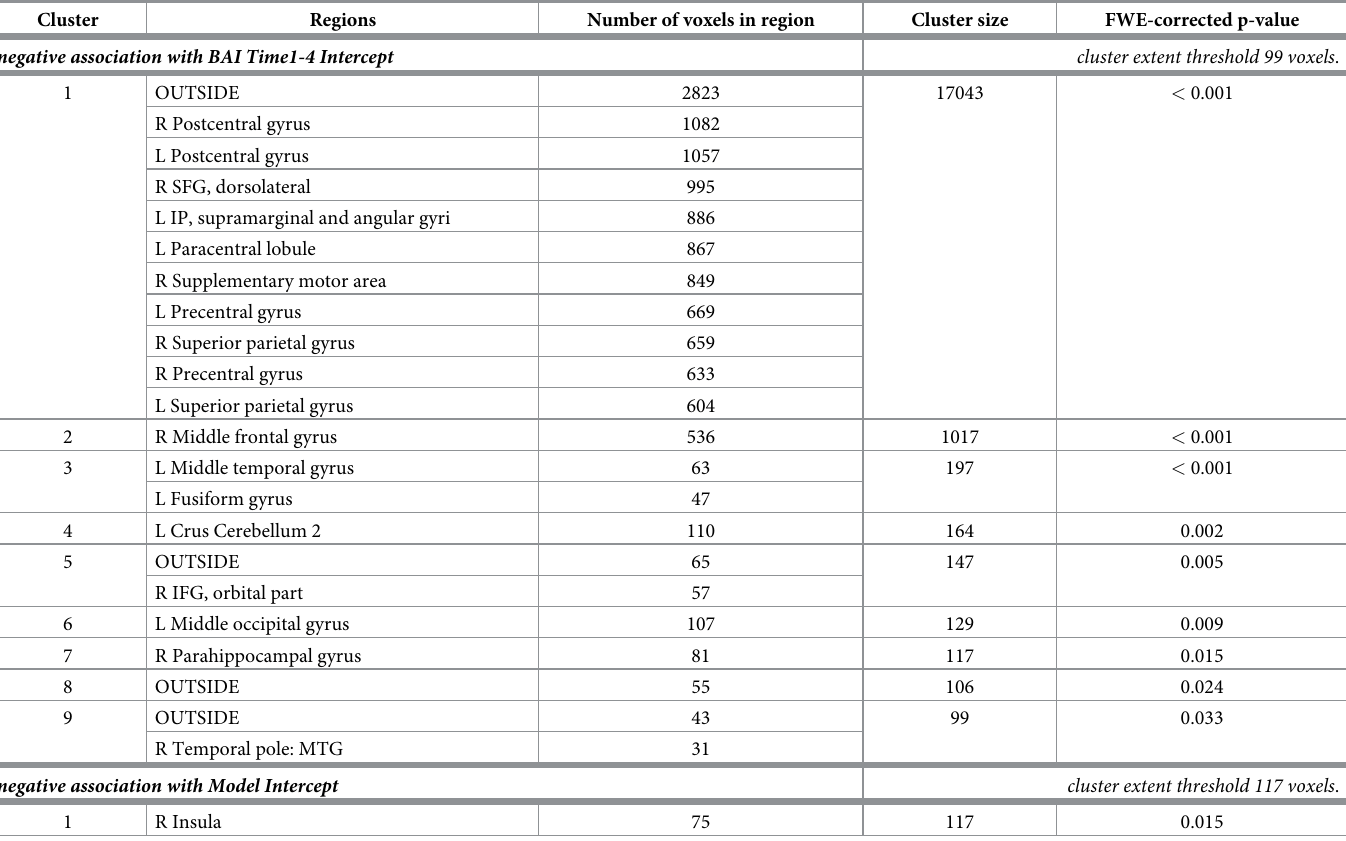
Table 5. Model of estimated future postpartum anxiety. Brain regions showing differences in maternal activation to own infant in positive versus negative emotion tasks (InfOwnPos > InfOwnNeg) related to increasing postpartum anxiety symptoms (BAI[T1-4]–estimated postpartum average anxiety). Cluster Regions Number of voxels in region Cluster size FWE-corrected p-value negative association with BAI Time1-4 Intercept cluster extent threshold 99 voxels